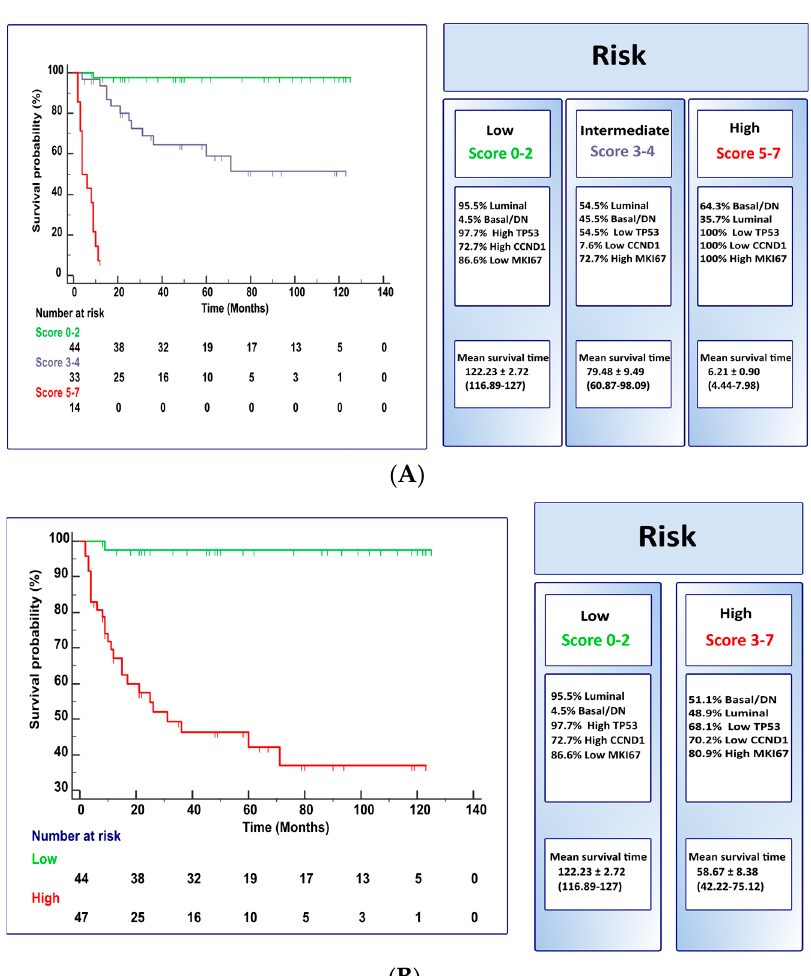
Figure 4. Kaplan-Meir plots for cancer-specific survival and risk scores stratified as two ( p < 0.0001;